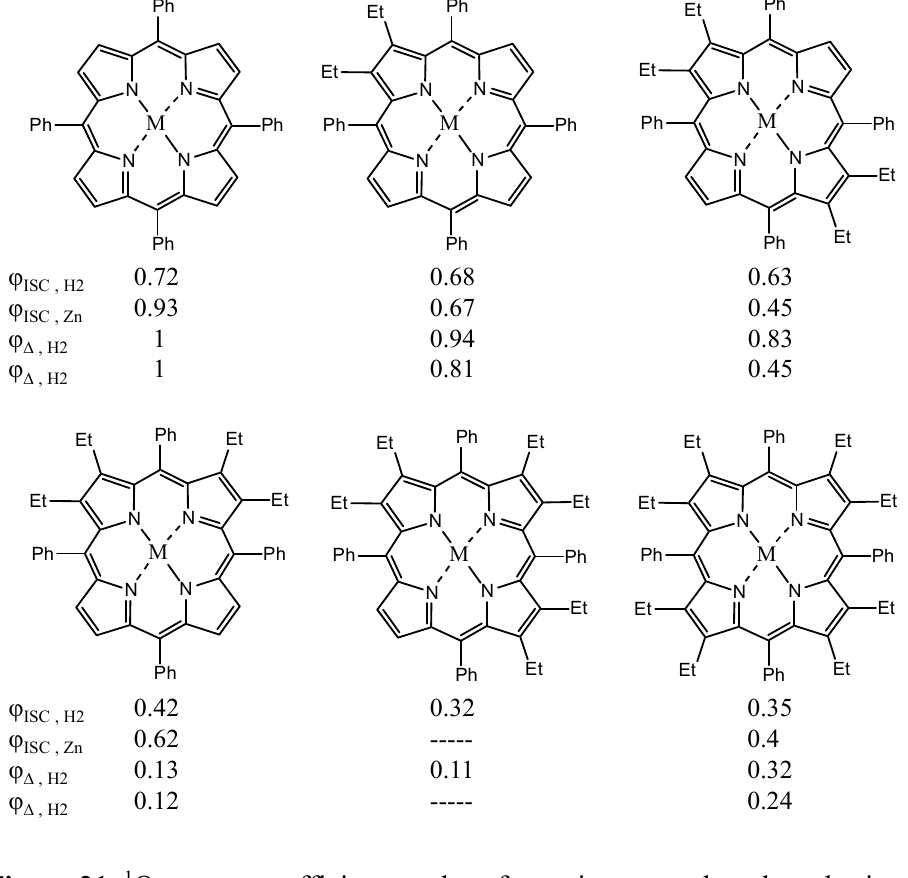
Figure 21. 1 O 2 quantum efficiency values for various tetraphenylporphyrins.